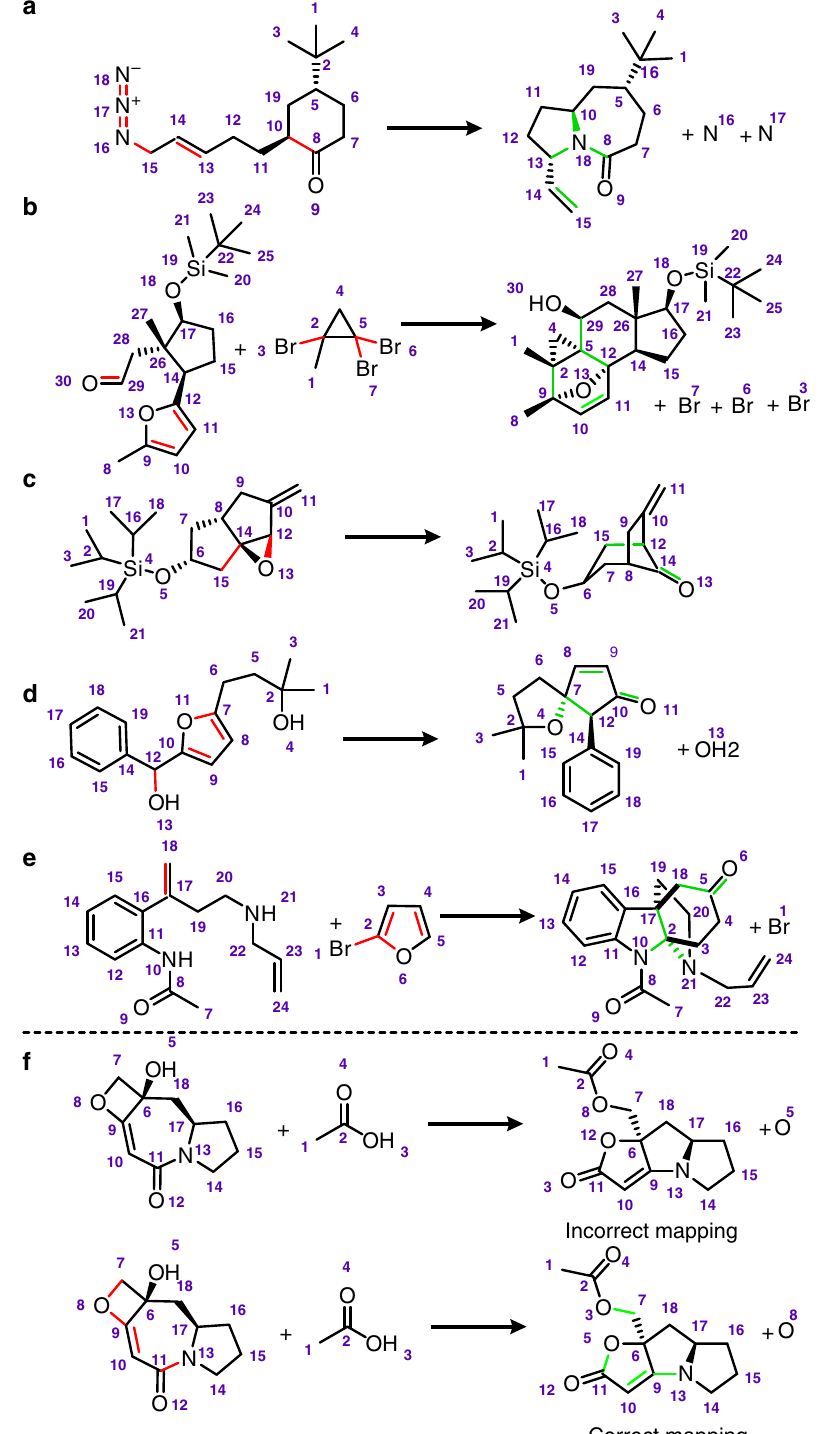
Fig. 6 Examples of mapped, complex reactions. a – e Reactions mapped correctly by our algorithm. f An example of a reaction in which the mapping found is incorrect. Correct mapping is shown in the bottom row. Bonds that are disconnected are colored in red whereas bonds created are marked green. For discussion, see main text and refs. 41 – 46 for chemical